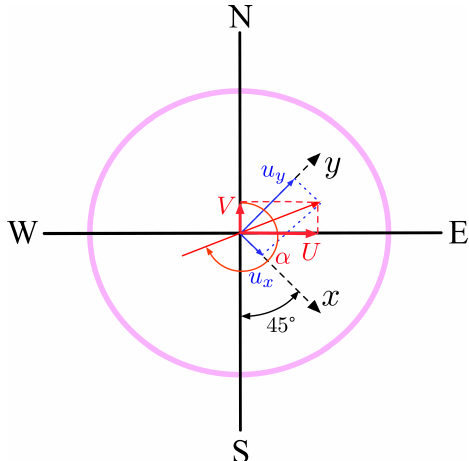
Figure 3. Illustration of the observation coordinate: u x and u y are the wind vector measured by the anemometer, which has a 45 ◦ angle against the northerly direction. The corresponding meteorological wind vector and direction can be retrieved via Eqs. (1) and